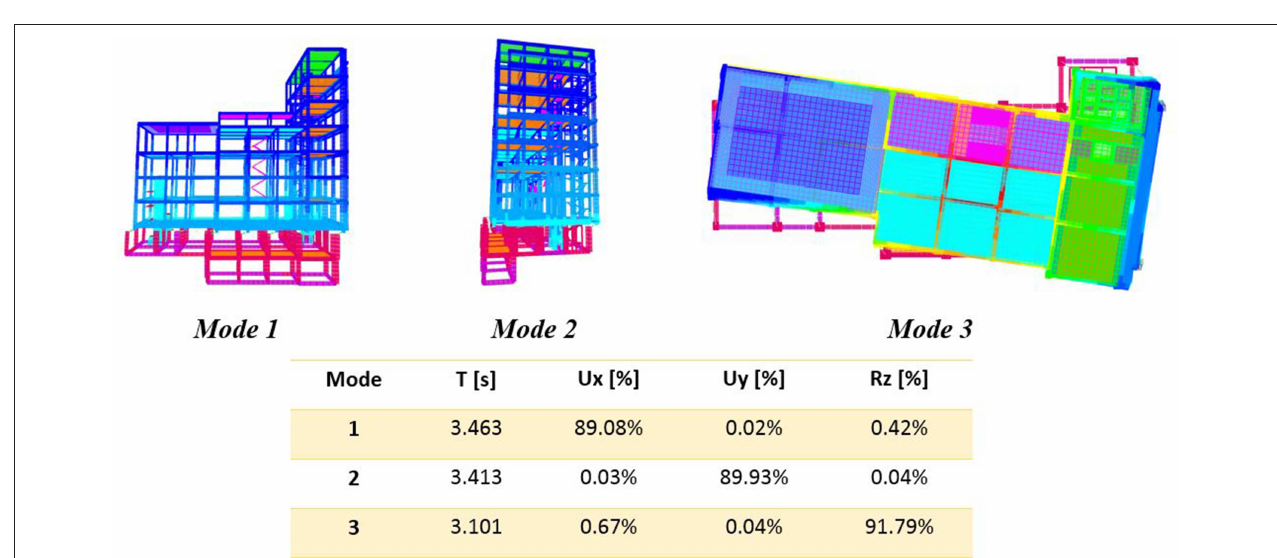
of interventions to improve the flexural capacity, in both cases the intervention consists in increasing of the column section and adding of longitudinal and transverse reinforcements.